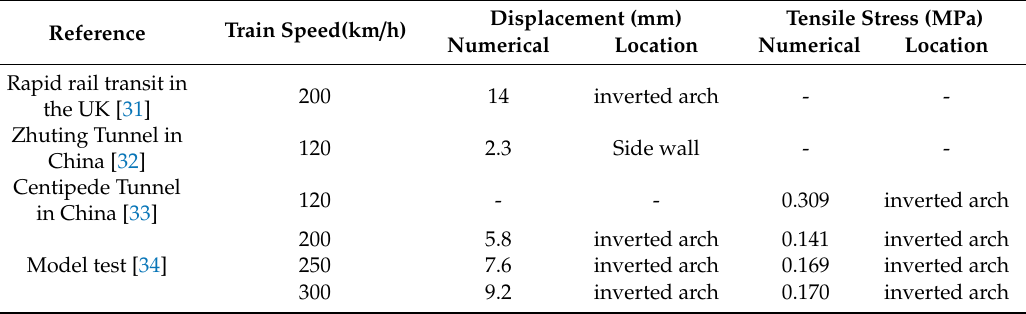
Table 3. Measured data of dynamic response of tunnel support structure under train loads.